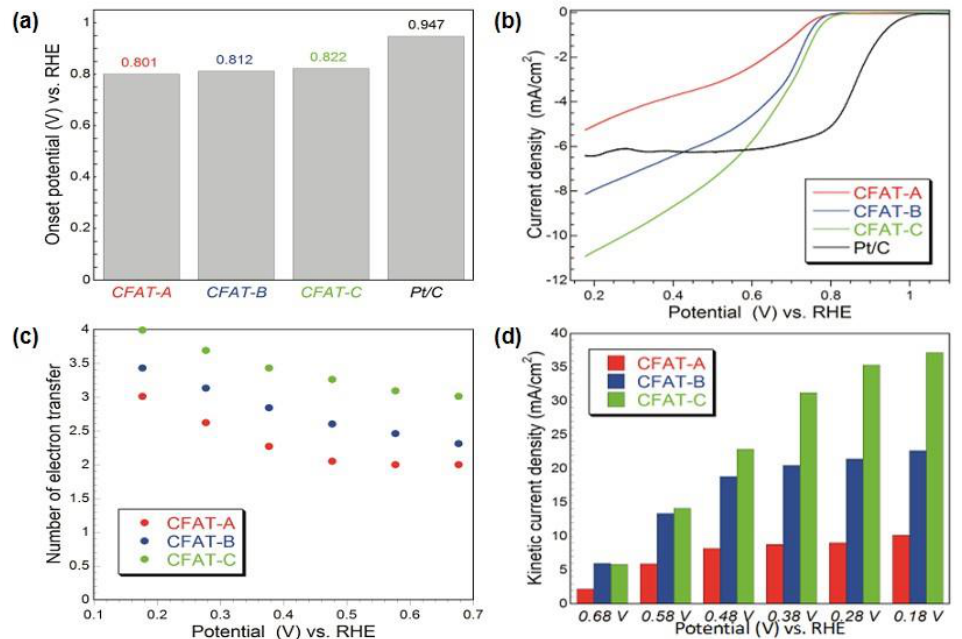
Figure 8. For the materials studied: ( a ) onset potentials; ( b ) linear sweep voltammograms on the modified glassy-carbon RDE in O 2 -saturated 0.10 MKOH at 2000 rpm and scan rate of 5 mV/s; ( c ) number of electron transfers versus potential; ( d ) kinetic current density. Reprinted with permission from Reference [53], Copyright 2016, American Chemical Society.